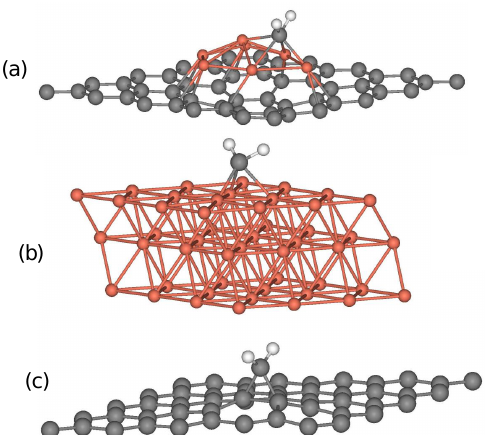
Figure 6. Schematic representation of the most energetically favourable adsorption positions of ∗ CH 2 intermediate on the top of ( a ) Cu 7 /graphene nanostructure, ( b ) Cu (111) surface, and ( c ) pris- tine graphene monolayer. Grey balls stand for carbon atoms, orange for copper, and white balls are